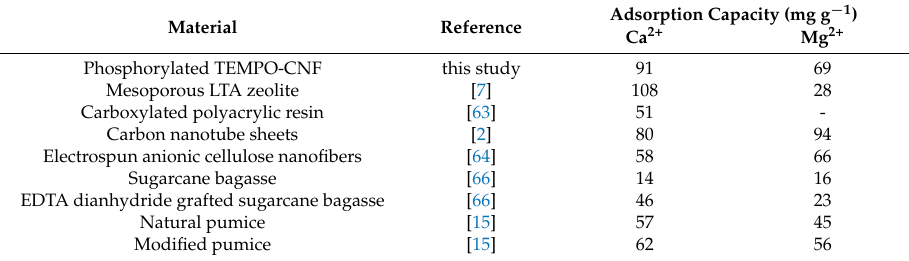
Table 3. Adsorption capacities for Ca 2+ and Mg 2+ compared to the literature.